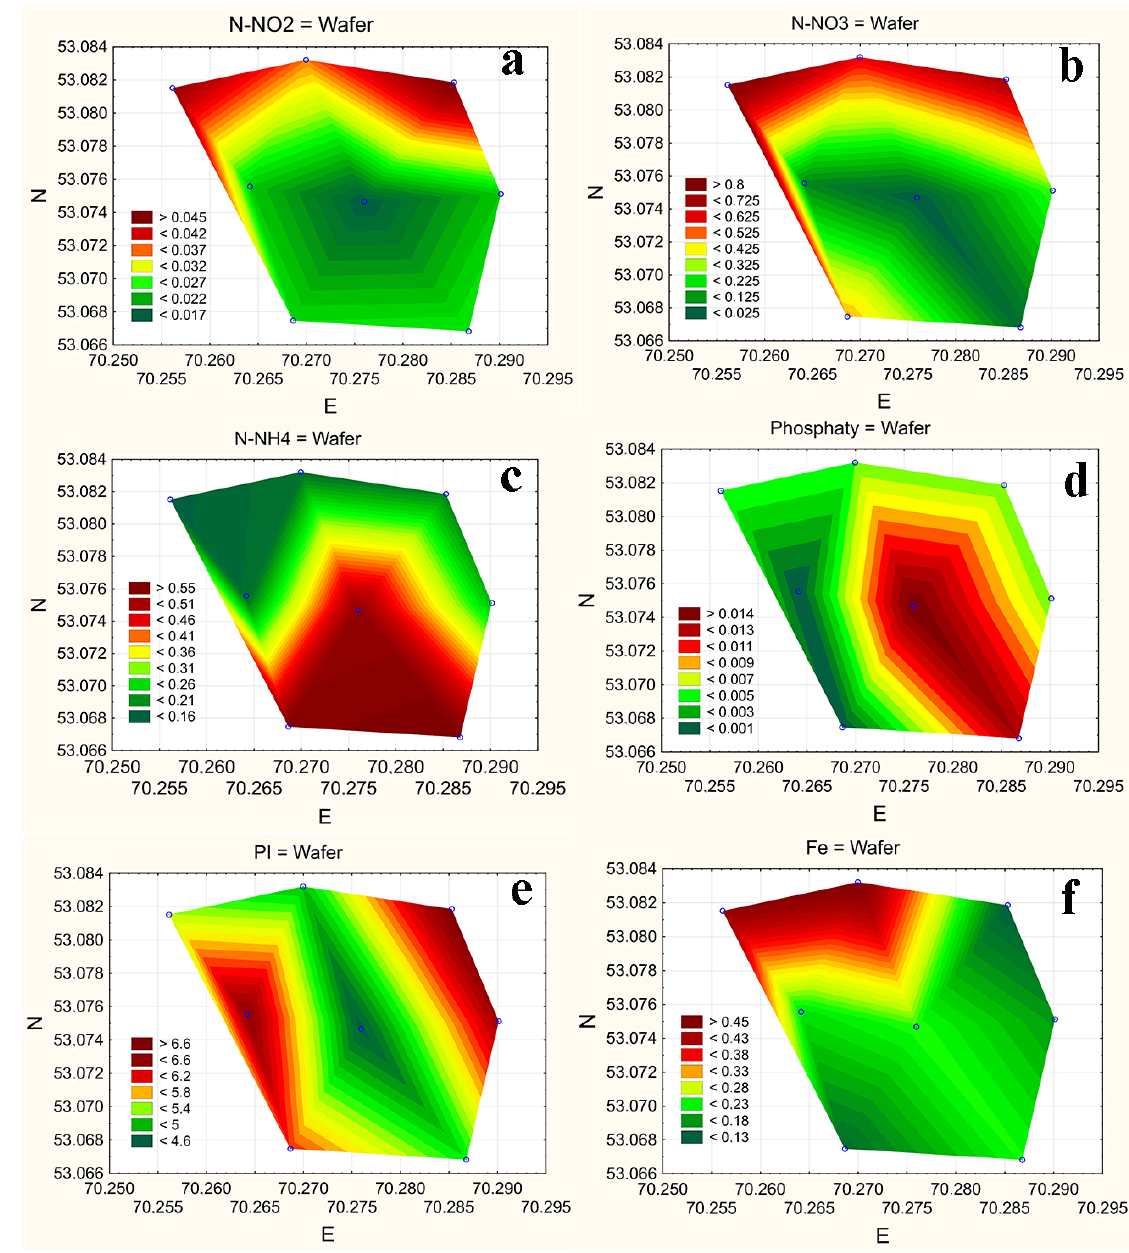
Figure 2. Spatial distribution of N-NO 2 ( a ), N-NO 3 ( b ), N-NH 4 ( c ), PO 4 ( d ), PI ( e ), and Fe ( f ) over the water area of the Borovoe Lake, 2019.